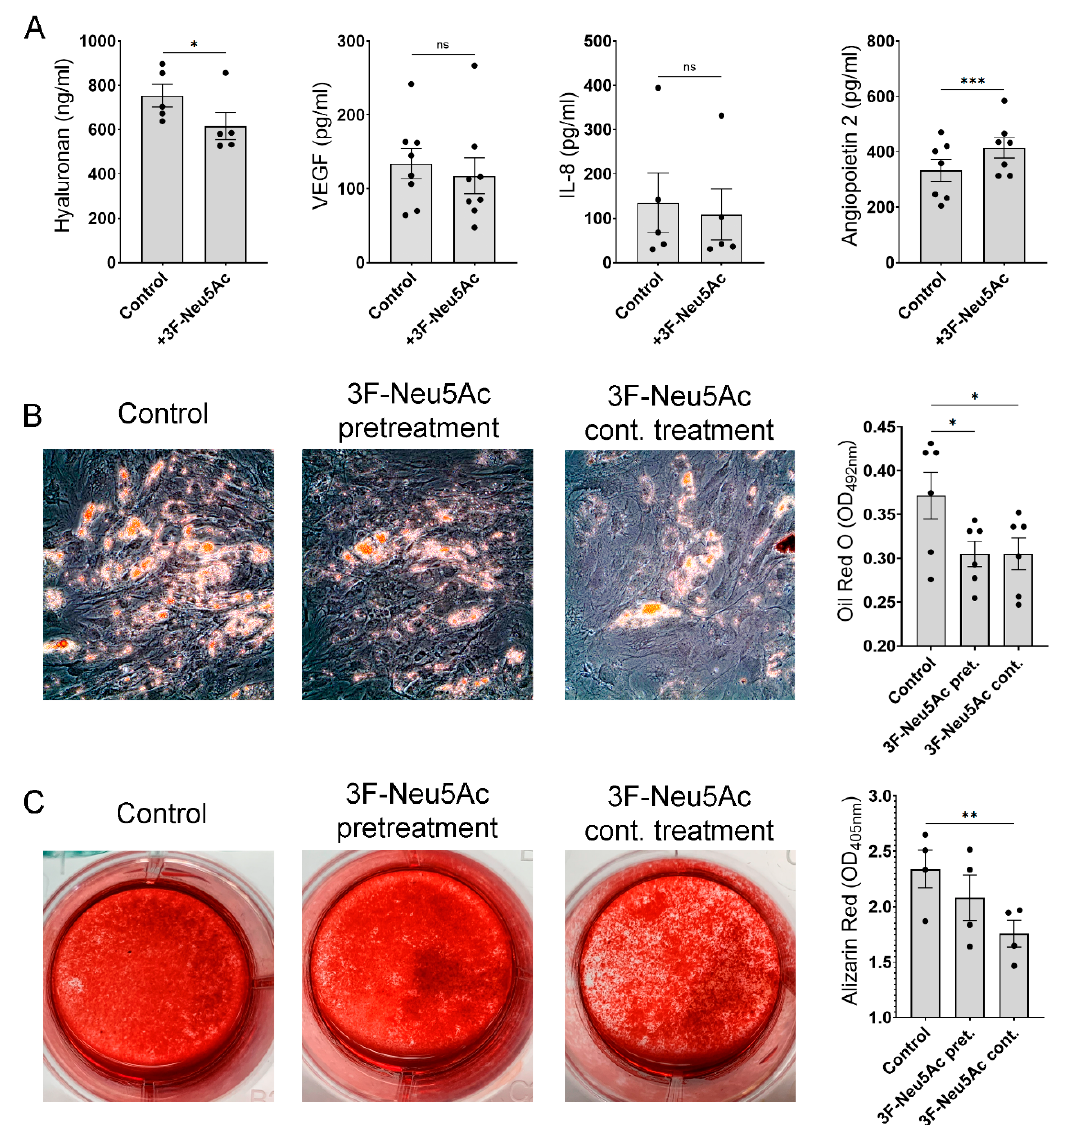
Figure 5. 3F-Neu5Ac affects the secretome and differentiation of MSCs. ( A ) MSCs were cultured for 2 days with or without 3F-Neu5Ac (50 μ M) and supernatants were collected for determination using ELISA for trophic factors. ( B ) Representative images of MSCs after 12 days in adipogenic media. Adipocytes were stained using Oil Red O (original magnification × 200). Oil Red O staining was subsequently quantified (n = 6). ( C ) Representative images of MSCs after 21 days in osteogenic media. Mineralized calcium is stained with Alizarin Red S. Quantification of Alizarin Red S (n = 4). ns: not significant; * p < 0.05; ** p < 0.005; and *** p < 0.0005.